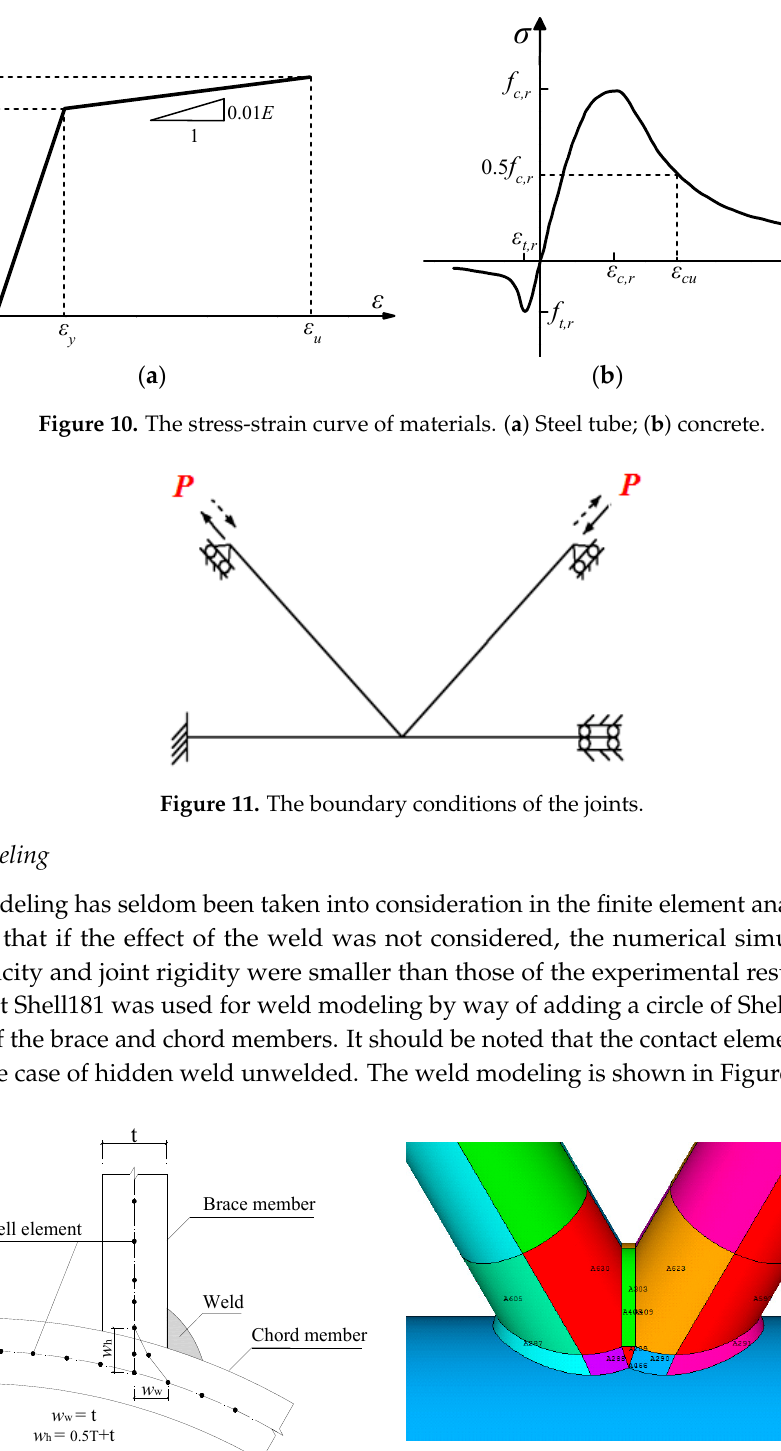
Figure 9. Finite element model of a joint. ( a ) K-CC; ( b ) K-RC.